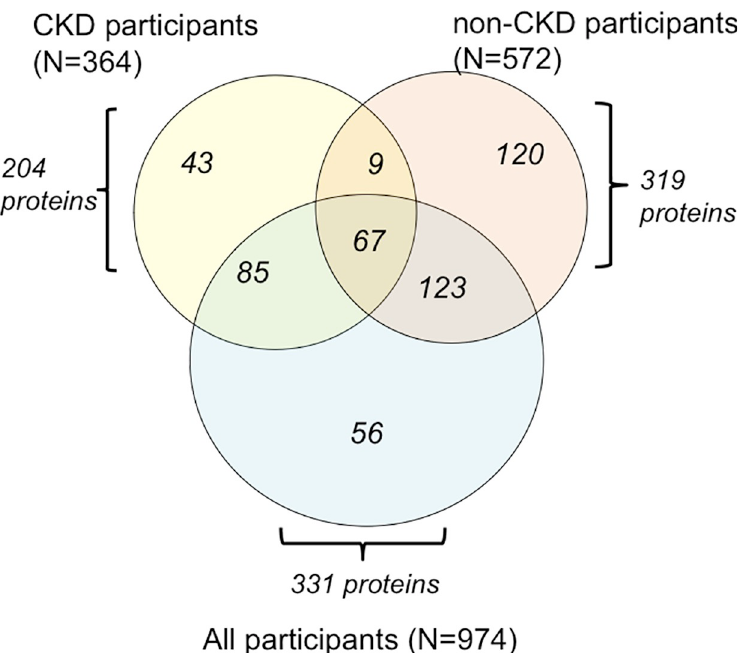
Fig 2. Results of random forest regression performed on full sample and sub-groups stratified by chronic kidney disease (See Attached File). Random survival forest regression was applied first to the full sample (N = 974 participants), then to the sub-groups with baseline CKD (N = 364 participants) and without baseline CKD (N = 572 participants). Forest regression of the full sample of participants yielded 331 proteins associated with HF outcomes (blue circle). Analysis of the sub-group with CKD resulted in 204 proteins (yellow circle), and analysis of the sub-group without CKD yielded 319 proteins (orange circle).